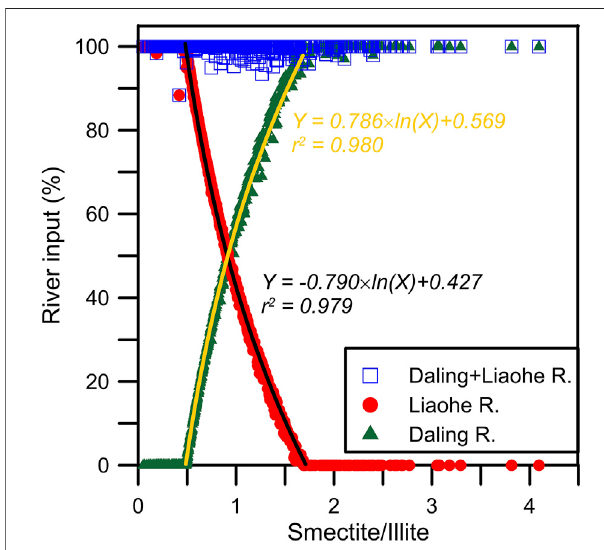
FIGURE10| Quanti fi cationofthecontributionoftheriverinputusingthe ratio of smectite content over illite content.